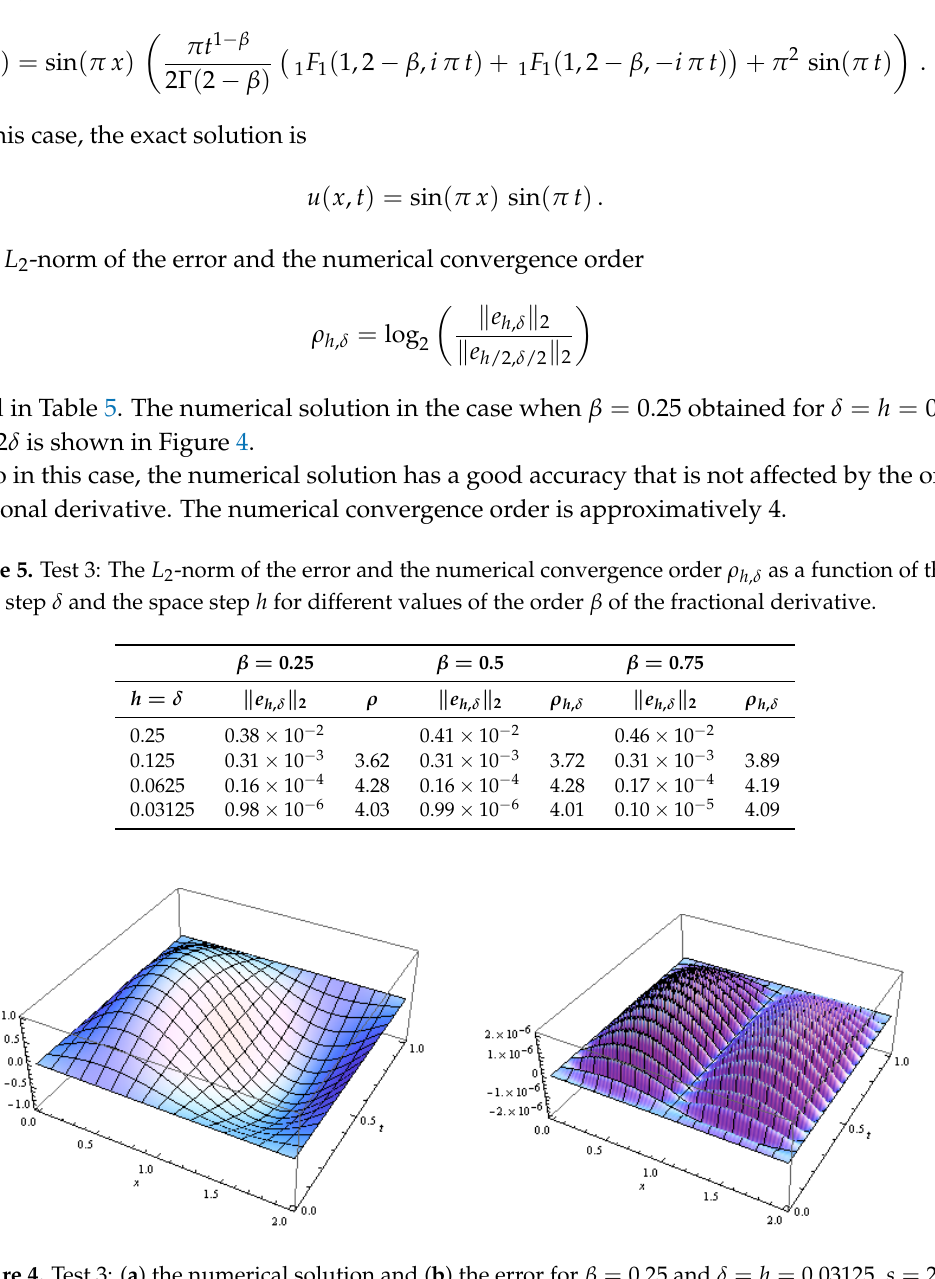
Figure 4. Test 3: ( a ) the numerical solution and ( b ) the error for β = 0.25 and δ = h = 0.03125, s = 2 δ